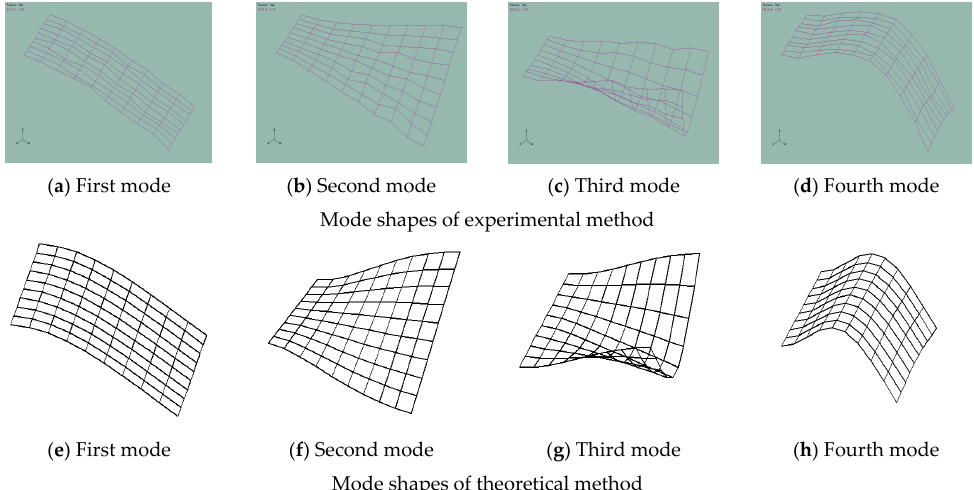
Figure 19. Comparisons of modal shapes of the laminated plate between measured and theoretical results. ( a ) First mode, ( b ) Second mode, ( c ) Third mode, ( d ) Fourth mode, ( e ) First mode, ( f ) Second mode, ( g ) Third mode, ( h ) Fourth mode.